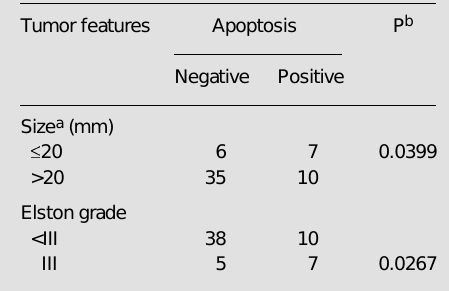
Table 1 - Number of patients presenting or not apoptotic peripheral blood cells in relation to tu- mor size and